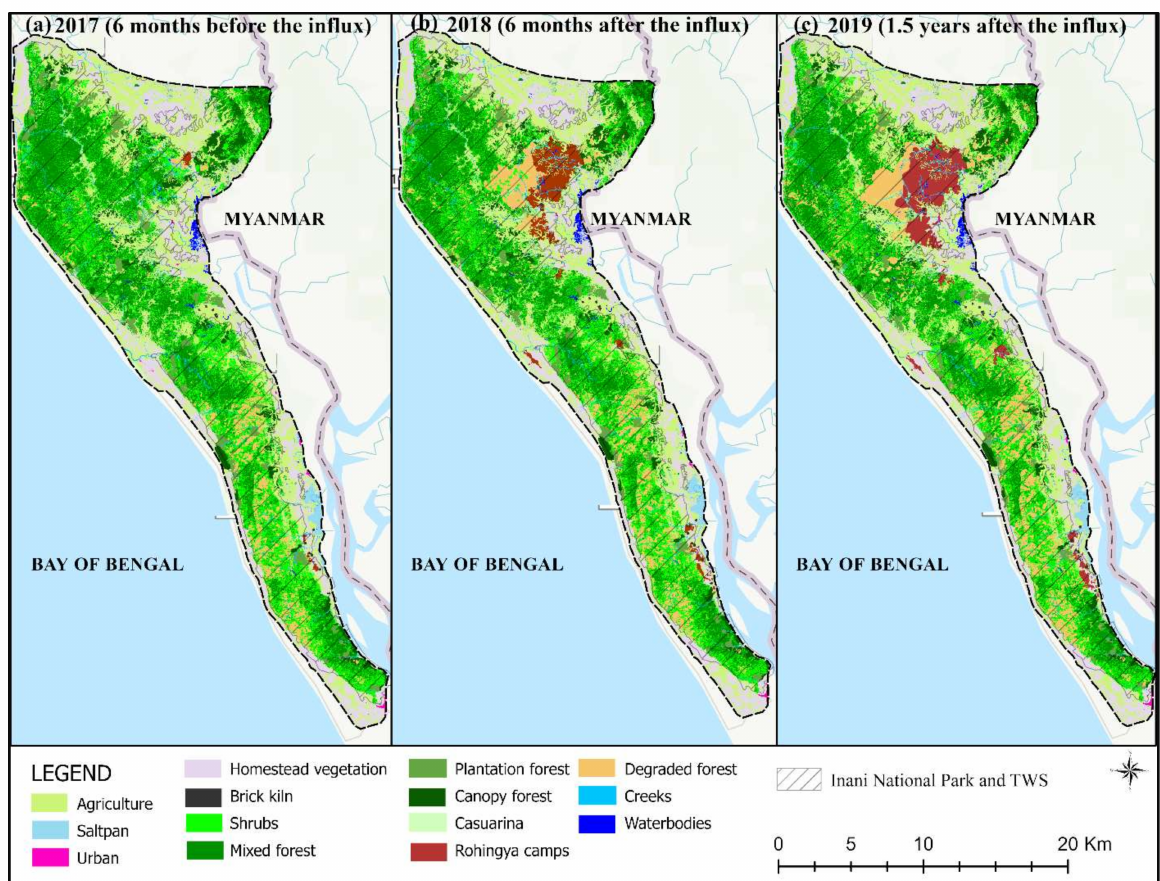
Figure 2. Time series (2017–2019) land use and forest cover map of the study area. ( a ) presents the scenario of the study area before the latest Rohingya influx (August 2017), where very few areas are observed as makeshift camps. ( b ) shows the scenario of the study area six months after the Rohingya influx (February 2018), where huge areas are observed as makeshift camps. Finally, ( c ) presents the scenario of the study area after one and half years of the influx (February 2019), where the growing trend in makeshift camps is